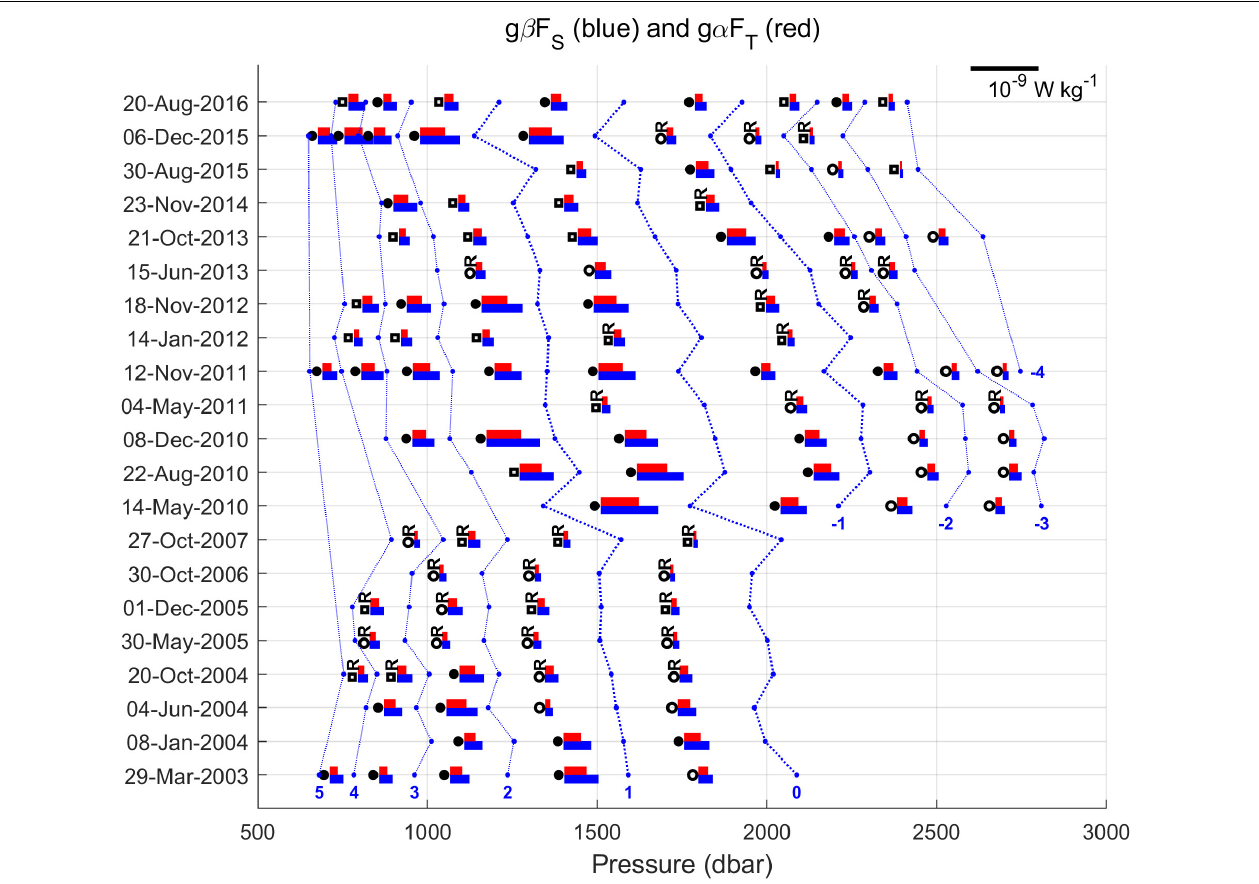
FIGURE 11 | The heat and salt contributions ( g α F T and g β F S ) to the buoyancy flux over time, calculated with RS12. Each value is represented by a colored bar: blue for the salinity and red for the temperature. The scale is 10 − 9 W kg − 1 . Sharp, slope and steppy interfaces are represented by a black circle, a white circle and a white square, respectively. Rough interfaces are identified with the capital letter “R.” A layer is delineated by a blue line running through its